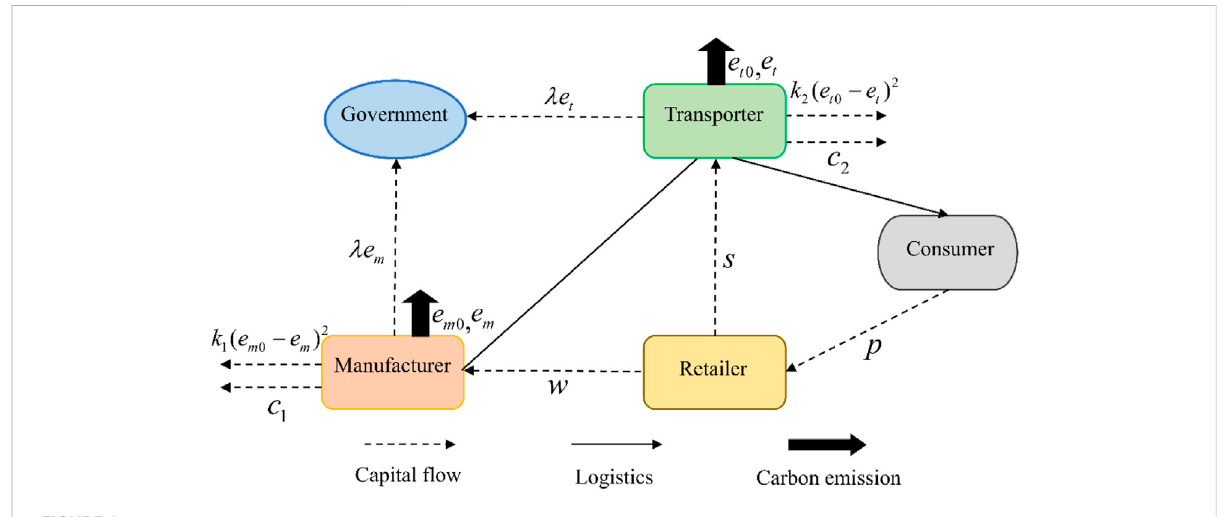
FIGURE 1 Operation chart of low-carbon supply